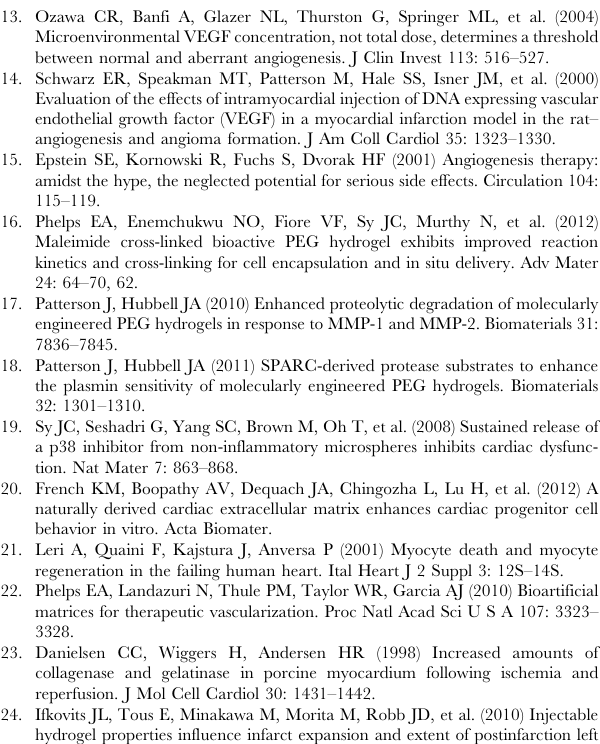
Figure 6. Invasive hemodynamic measurement of function. Grouped data (mean 6 SEM; n $ 7 per group) taken 21 days following injury by cardiac catheterization. A-F) Various measures of function demonstrate a significant improvement in all but 1 measurement (C, end-systolic developed pressure) in PEG/HGF/VEGF treated rats compared to IR alone (*p , 0.05; **p , 0.01; ANOVA followed by Student-Newman-Keuls post-test). PEG=polyethyleneglycol, VEGF=vascular endothelial growth factor, HGF=hepatocyte growth factor, IR=ischemia reperfusion, ESDP=end-systolic developed pressure, EDDP=end-diastolic developed pressure, ESV=end-systolic volume, EDV=end-diastolic volume, 6 dP/dT=change in pressure over